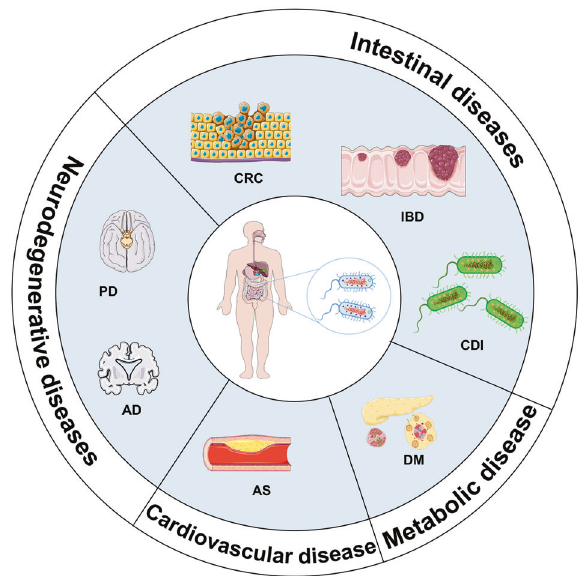
Fig. 5 Microbial modulation for disease treatment. AD Alzheimer ’ s disease, PD Parkinson ’ s disease, CRC colorectal cancer, DM diabetes mellitus, CDI Clostridium dif fi cile infection, IBD in fl ammatory bowel disease, AS